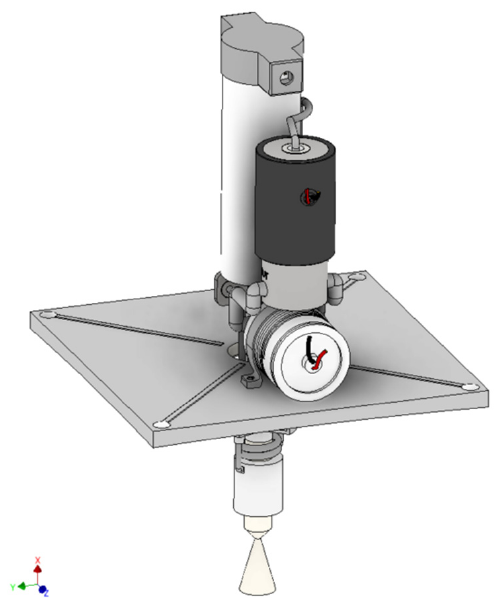
Figure A2. Feed and pressurization system (Micro electric pump feed cycle–Autogenous pressuri- zation).